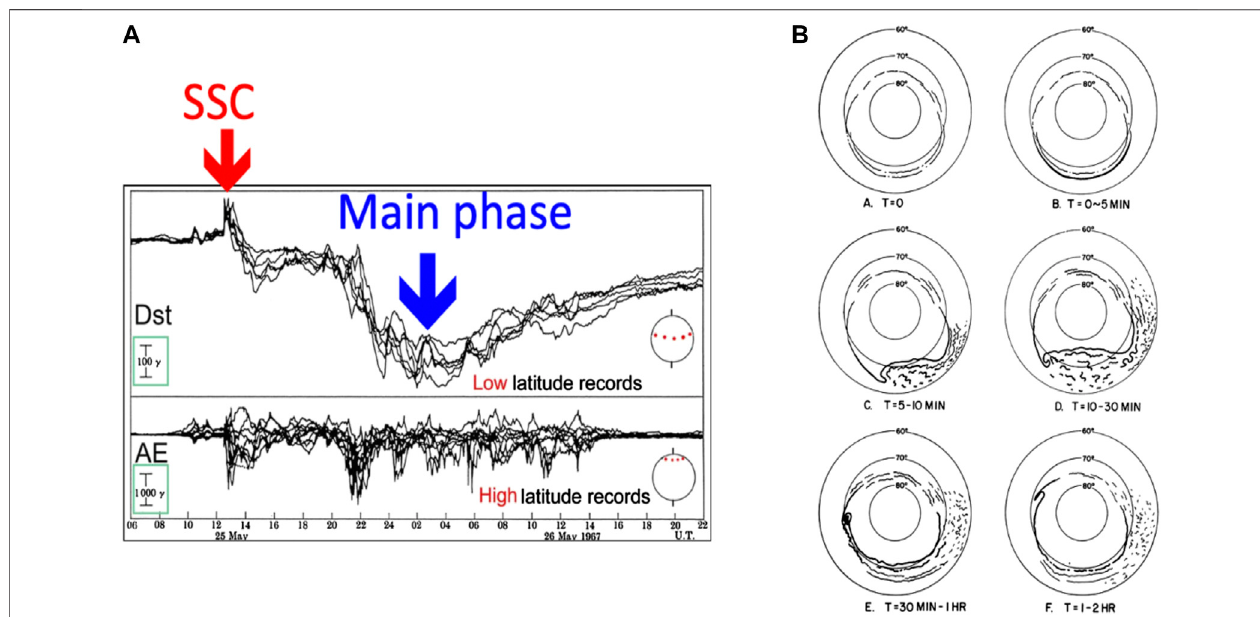
FIGURE 1 | (A) An example of geomagnetic storms, indicating the storm sudden commencement (ssc) and the main phase decrease (a large decrease of the H component). (B) A schematic illustration showing the development of an auroral substorm.